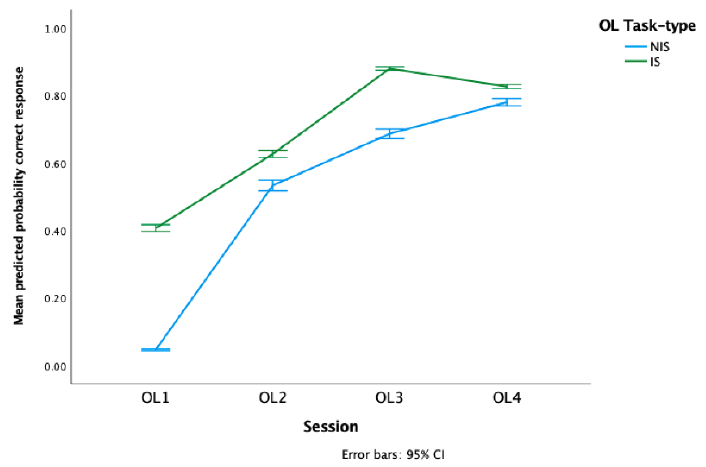
Figure 3. Mean predicted probability of a correct responses per trial during the original learning sessions. OL 1 – 4 = individual original learning sessions.